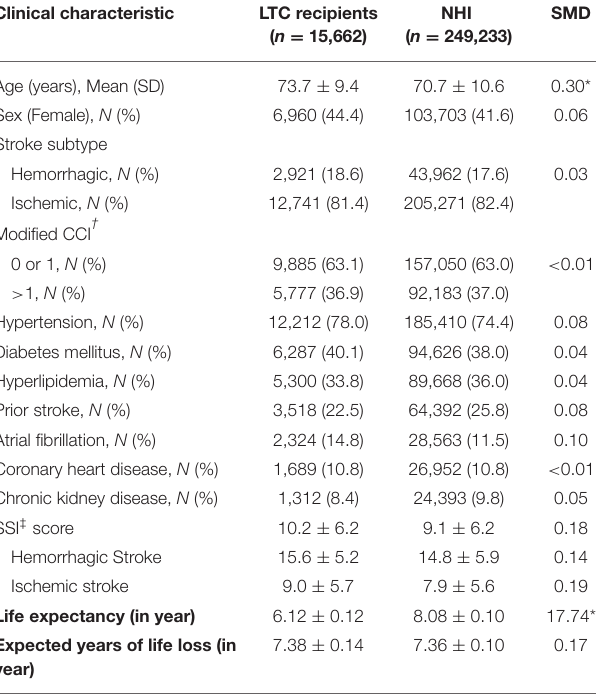
TABLE 2 | The prevalence and means of clinical characteristics at baseline of TABLE 1 | The profile (sociodemographics and functional disabilities) of the patients with stroke receiving LTC among those hospitalized through National long-term care (LTC) recipients with stroke from 2011 to 2016. Health Insurance (NHI) of Taiwan during N (%) Age p -value